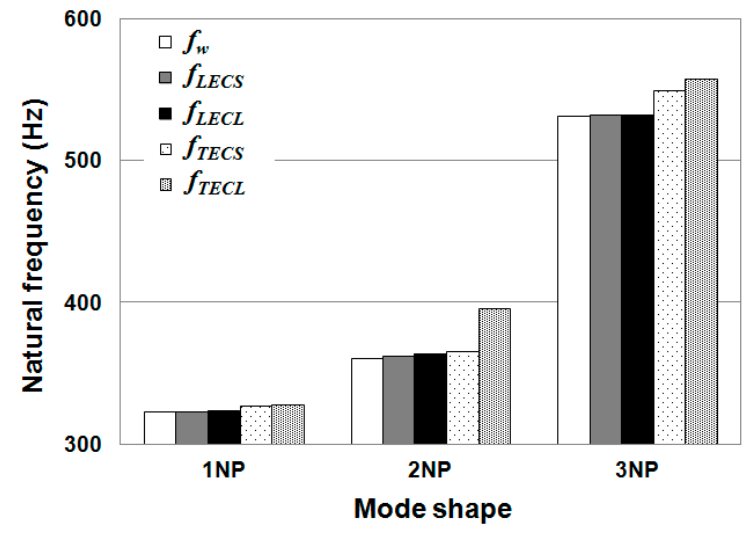
Figure 7. Natural frequencies of the single blade with pure water and with different cavities.